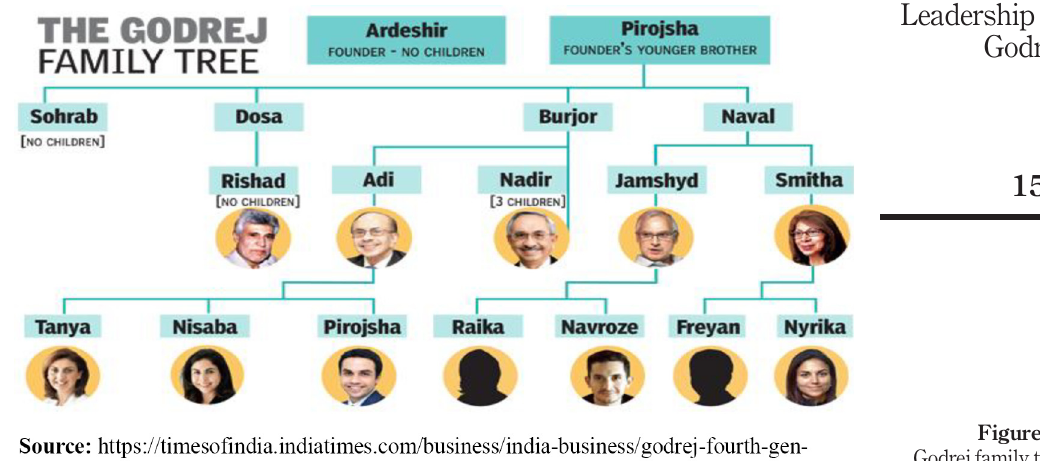
Figure 1. Godrej family